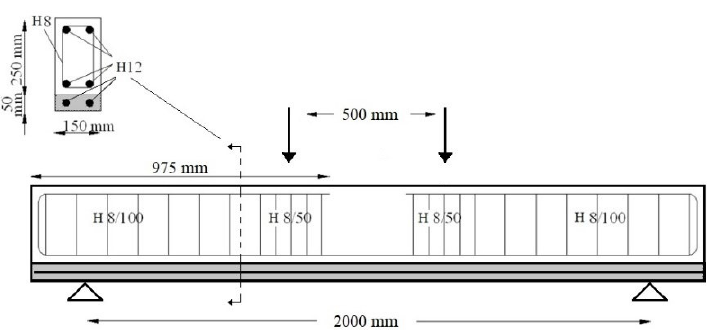
Figure 15. Geometry and reinforcement details of the strengthened beams. Adapted from [42].